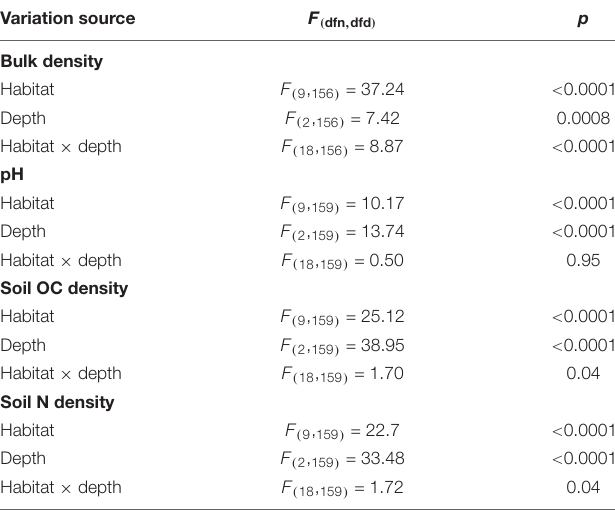
TABLE 5 | Results of a two-way ANOVA statistical tests for bulk density (g cm − 3 ), pH, soil organic carbon (OC) density (mg cm − 3 ), and soil nitrogen (N) density (mg cm − 3 ).